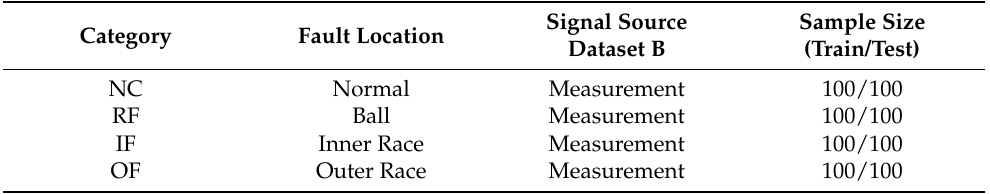
Figure 7. Rotating machinery fault diagnosis experimental device. Table 2. Situation of Dataset